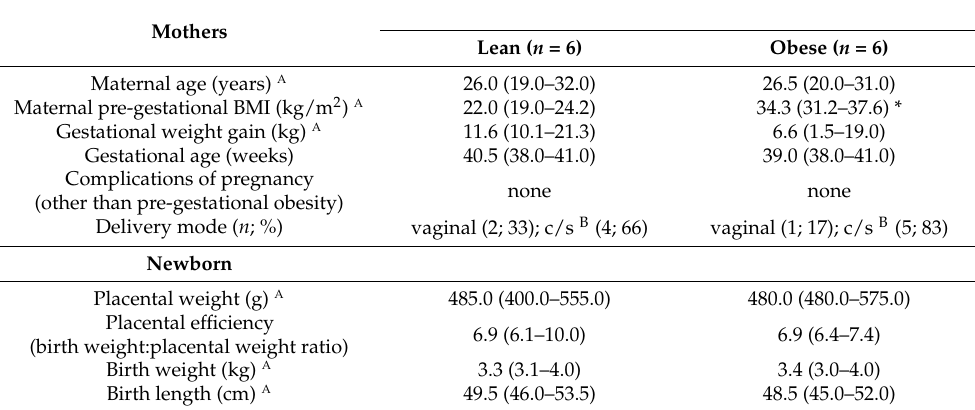
Table 1. Clinical characterization of the mothers and newborns participating in the study.